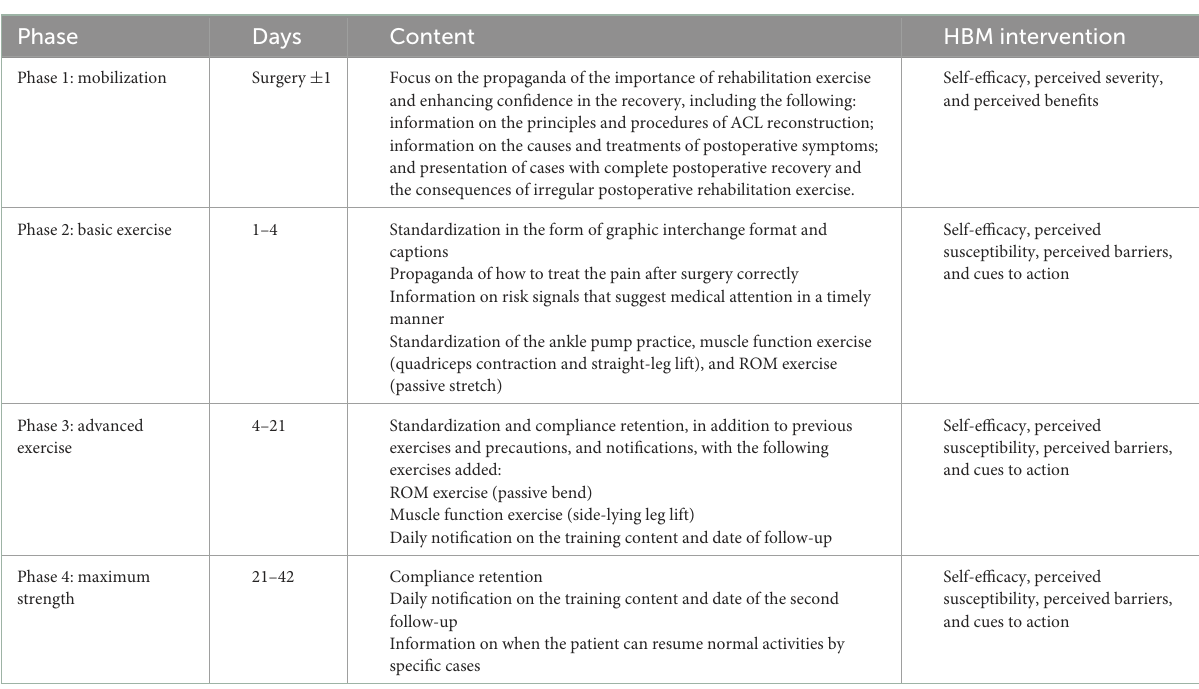
TABLE 1 Rehabilitation exercise education after ACL